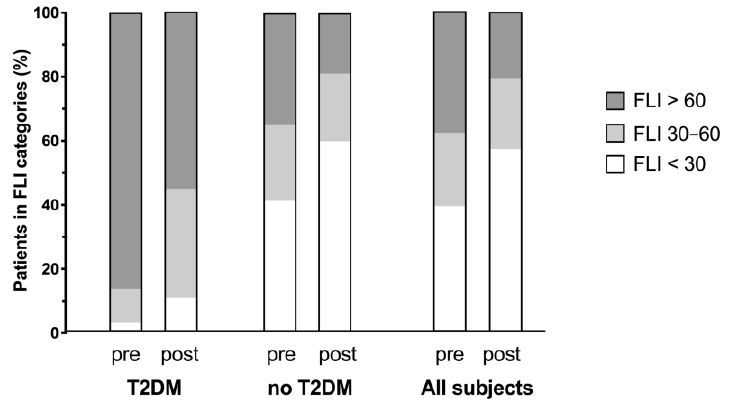
Figure 2. Frequency distribution of FLI categories before and after therapeutic fasting in patients with T2DM ( n = 38), in non-diabetic subjects (no T2DM; n = 659), and in all subjects ( n = 697).